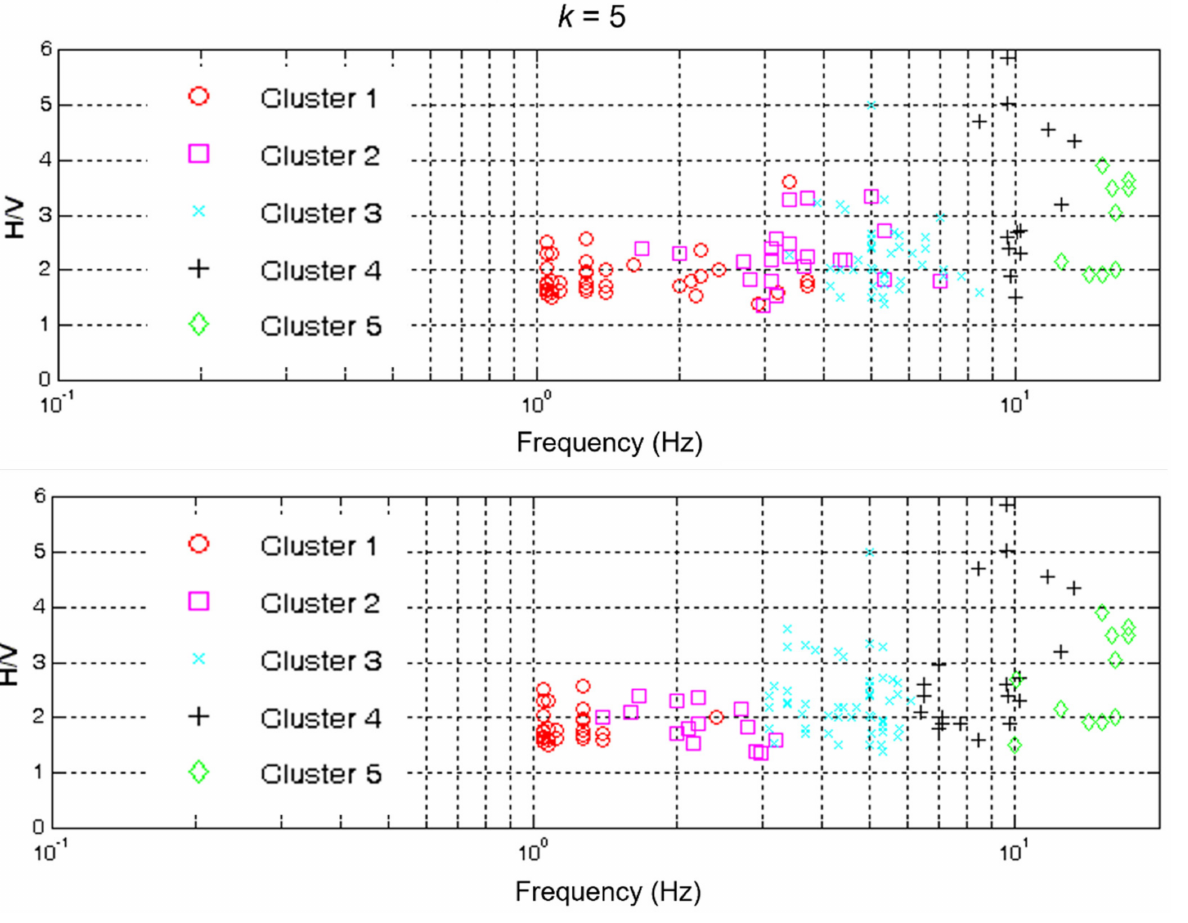
Figure 2. Comparison between the distribution in the frequency domain (peaks of H / V as the fre- quency varies) of the points of the clusters, obtained by performing a preliminary analysis of the data ( top ) and by applying the non-hierarchical algorithm with automatically chosen centroids ( bottom